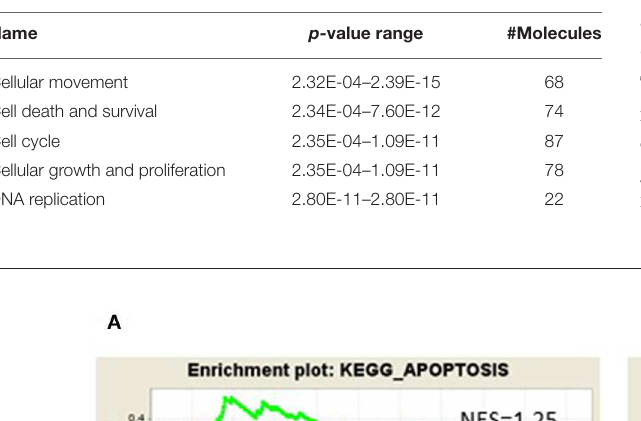
TABLE 1 | Molecular and cellular functions analysis of differential gene expression in HGK-treated oral cancer cells.